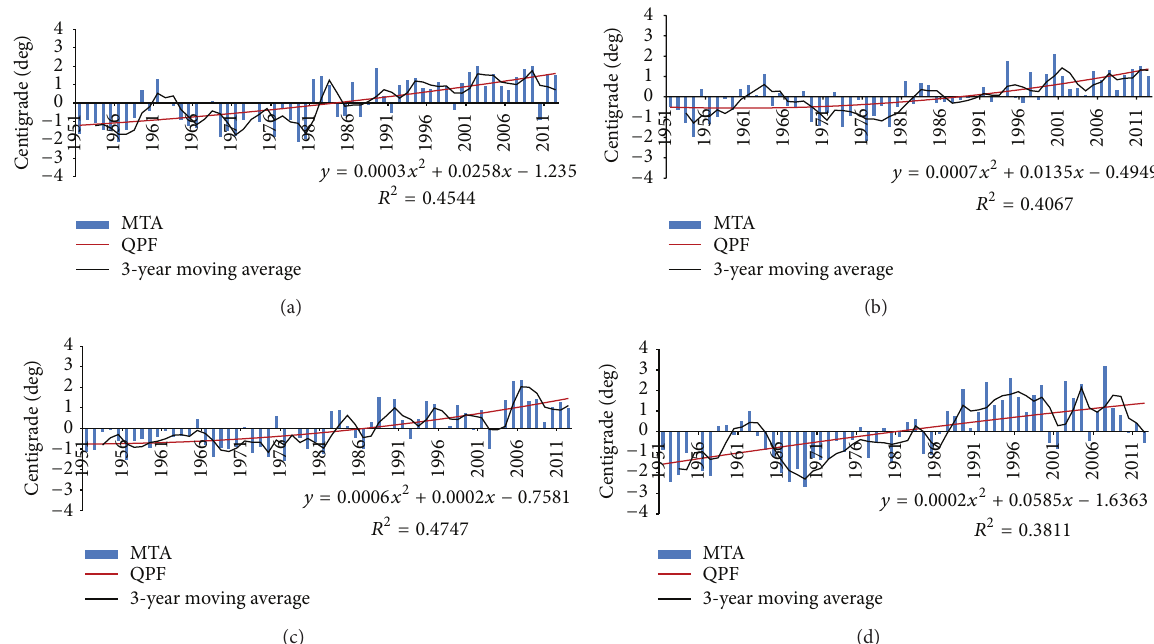
Figure 3: The Mean Temperature Anomaly (MTA), Quadratic Polynomial Fitting (QPF), and a 3-year moving average of the mean temperature of spring (a), summer (b), autumn (c), and winter (d) of Guan Xiang Tai (GXT) in the period of 1951–2012.